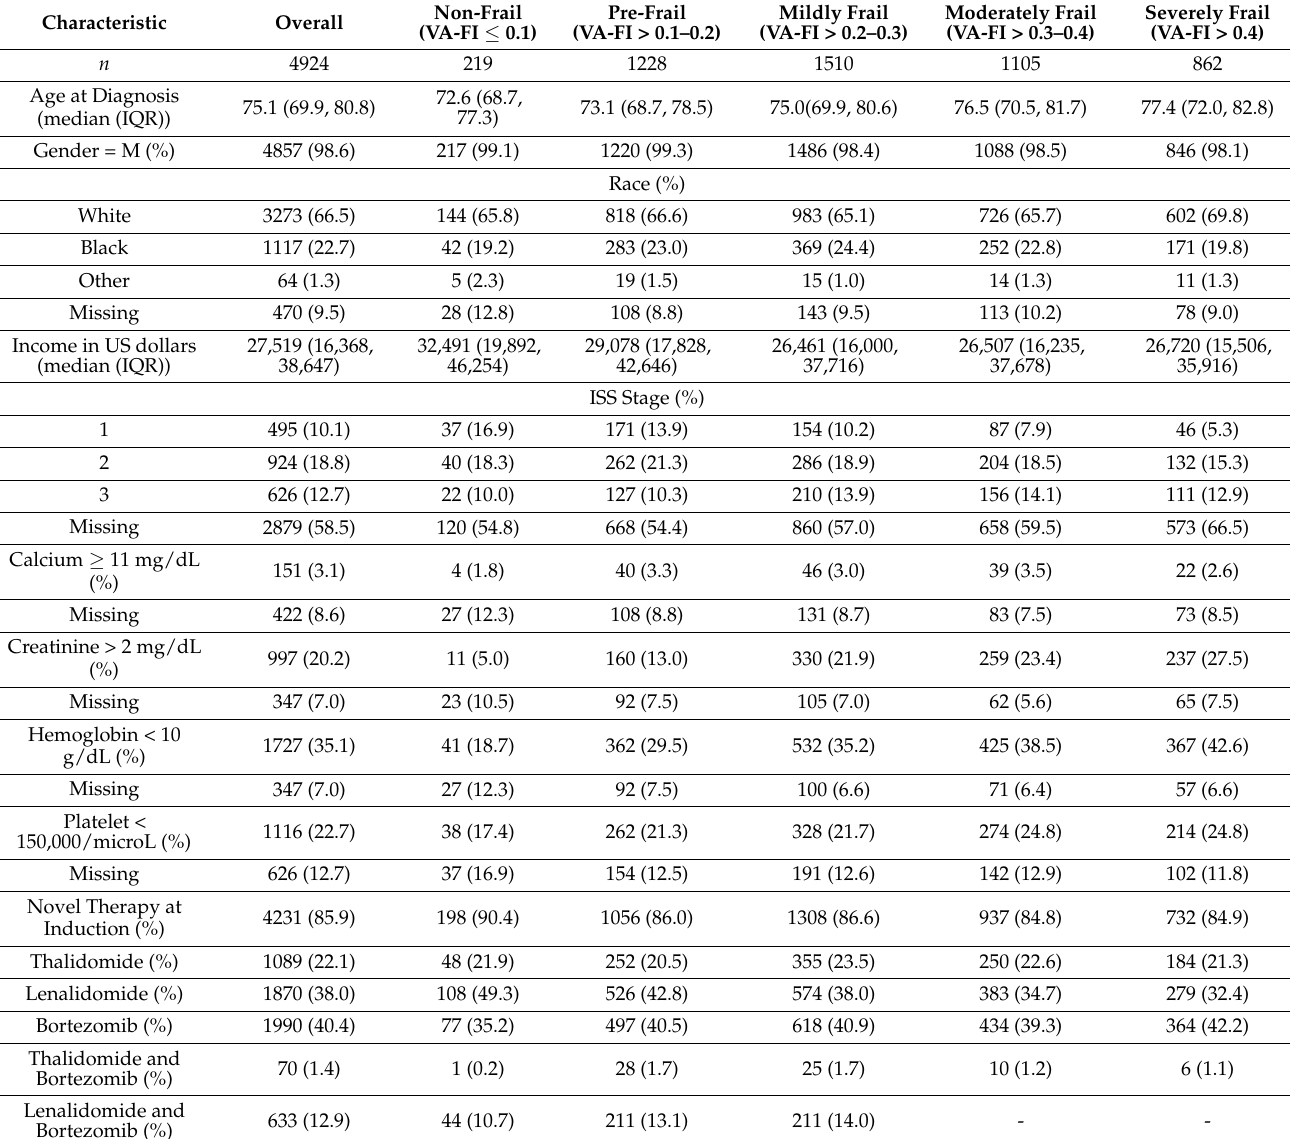
Table 1. Baseline characteristics of 4924 veterans with MM according to VA-FI-10